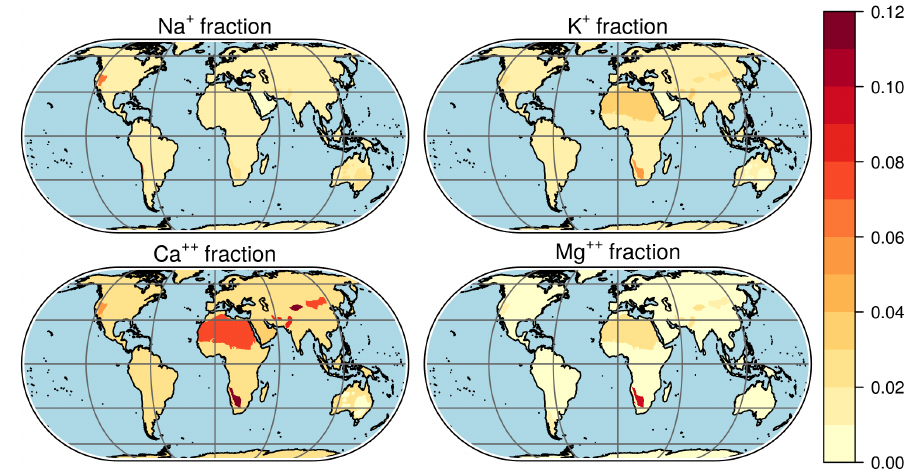
Figure 6. Maps of the Na + , K + , Ca ++ and Mg ++ mass fractions of the soil of different desert regions, used to calculate the chemical composition of the emitted dust particles.